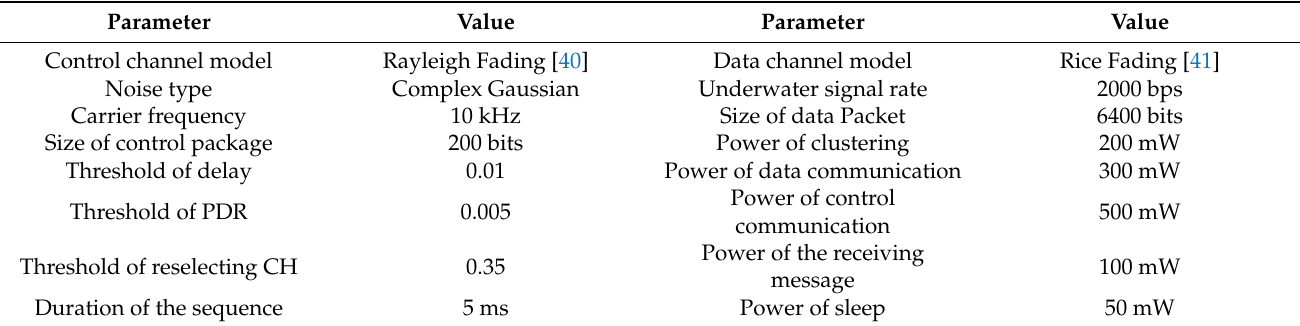
Table 4. Experimental parameters.